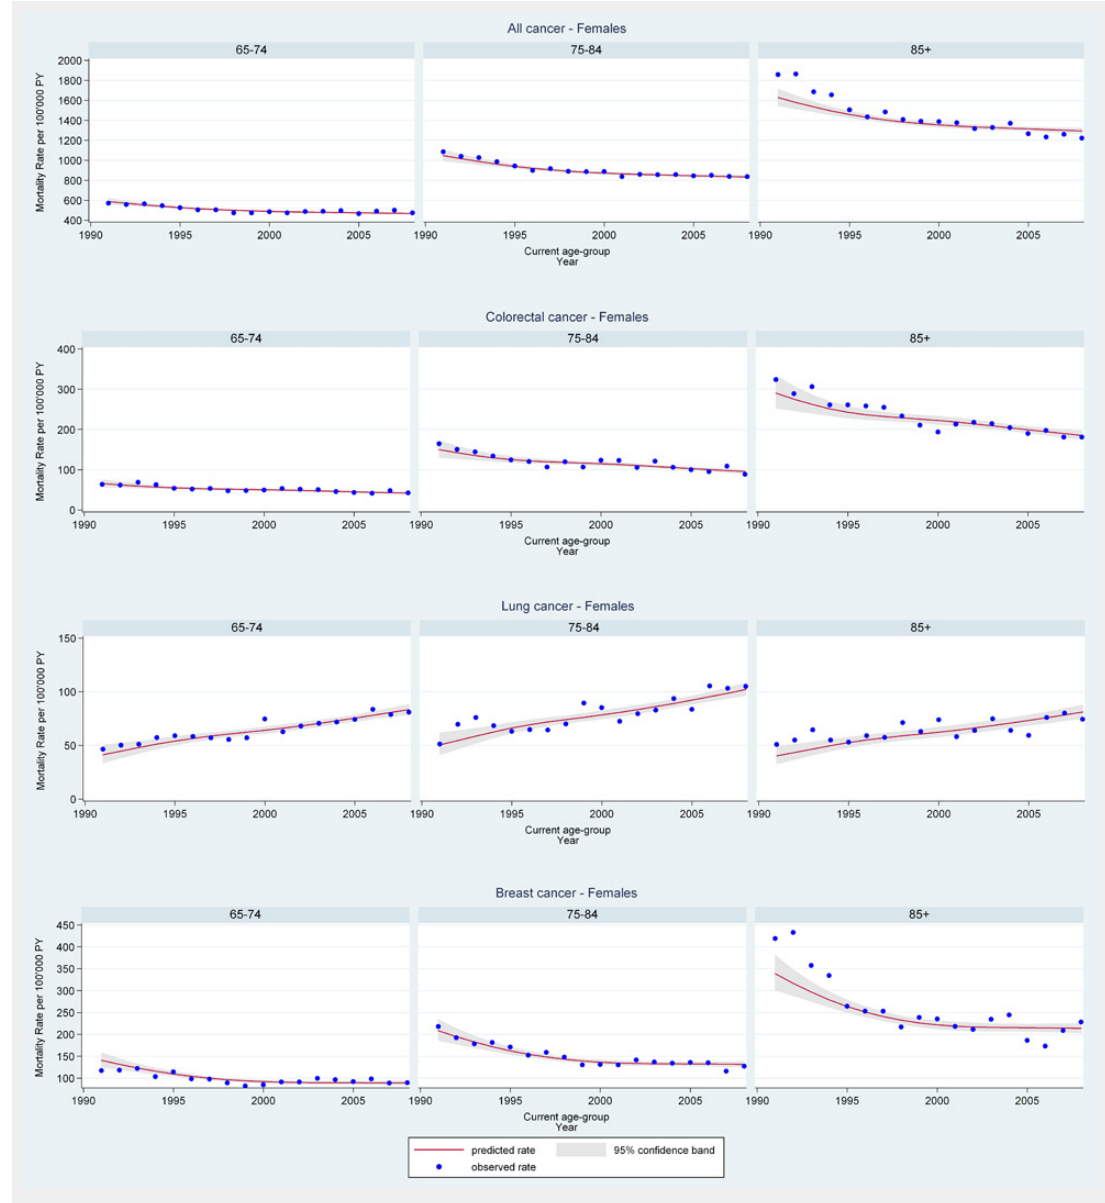
Figure 2 Age-specific cancer mortality from 1991 through 2008 in Swiss women ≥65 years